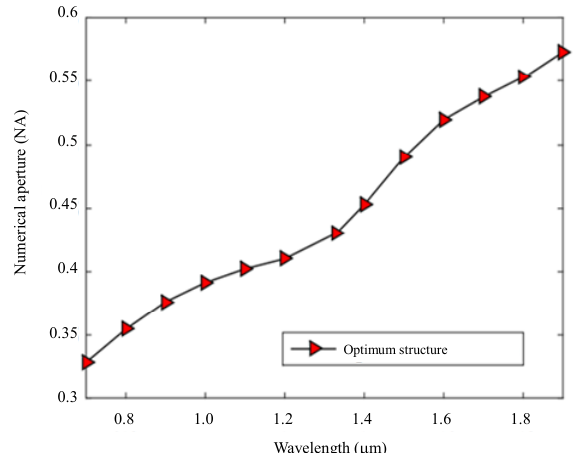
Fig. 8 NA as a function of wavelength for the optimum structure.